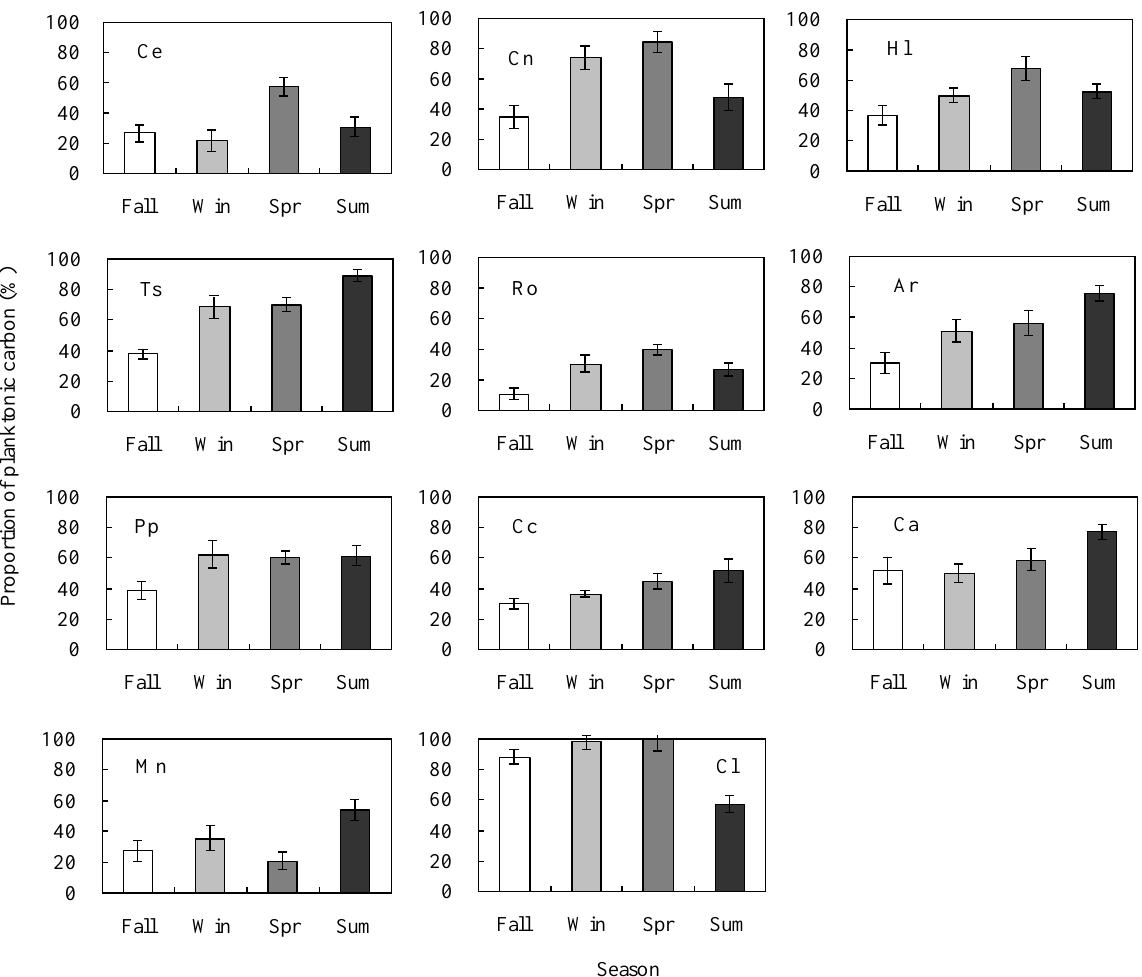
FIGURE 3 . The proportional contribution of planktonic carbon to 11 consumer species in Meiliang Bay (Lake Taihu) in different seasons based on the two-source mixing model. Ce: Cultrichthys erythropterus ; Cn: Coilia nasus ; Hl: Hemiculter leucisculus ; Ts: Toxabramis swinhonis ; Ro: Rhodeus ocellatus ; Ar: Abbottina rivularis ; Pp: Pseudorasbora parva ; Cc: Cyprinus carpio ; Ca: Carassius auratus ; Mn: shrimp Macrobrachium nipponense ; Cl: Chironomid larvae. Fall, Win, Spr, and Sum in the diagram represent fall, winter, spring, and summer,